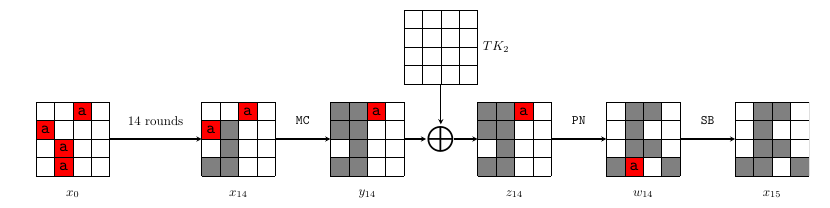
Figure 15: A 15-round truncated differential trail of CRAFT with probability 2 −